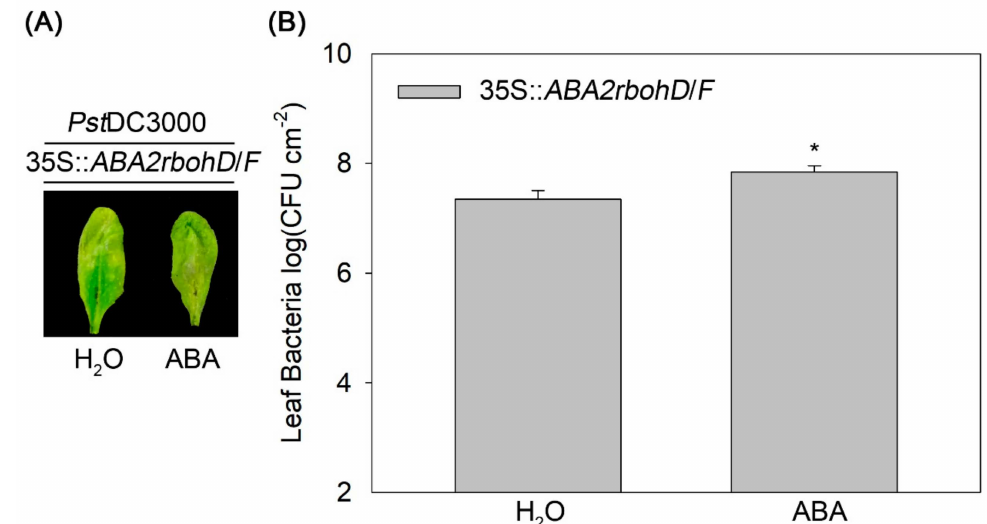
Figure 4. E ff ects of RBOHD and RBOHF on Pst DC3000 resistance in the ABA2 transgenic Arabidopsis line 35S:: ABA2 at 3 dpi. ( A ) Disease symptoms and ( B ) bacterial growth. 35S:: ABA2rbohD / F plants were treated with distilled water (H 2 O) or abscisic acid (ABA) prior to inoculation with Pst DC3000. Error bars indicate the standard error, and values were based on eight independent replicates. Asterisk indicates a significant di ff erence ( t -test, p < 0.05). These experiments were performed at least three